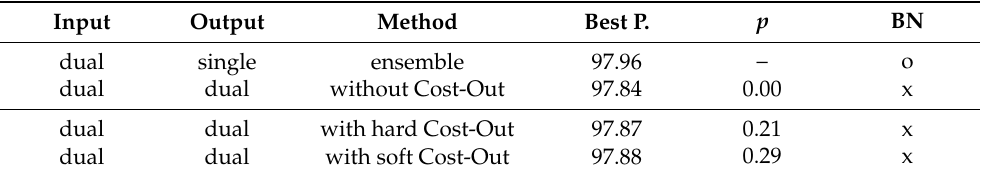
Table 4. Best performance in the test set of TDC-same task. Common best configuration: Adam, no